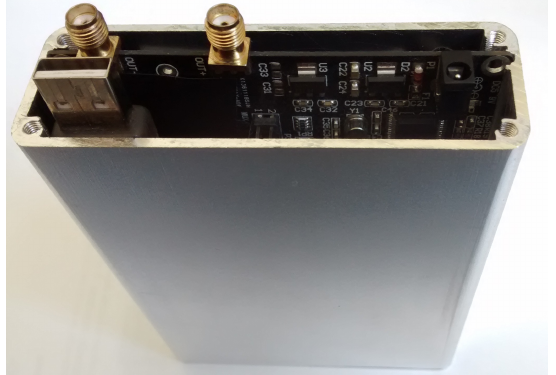
Figure 3. Detail of the transmitter board inside the aluminum case. The USB connector (universal serial bus), used for receiving configurations from the computer, and two RF SMA connectors [2] (only one was used and the other was turned off during the tests) are shown. The power connector is on the right.